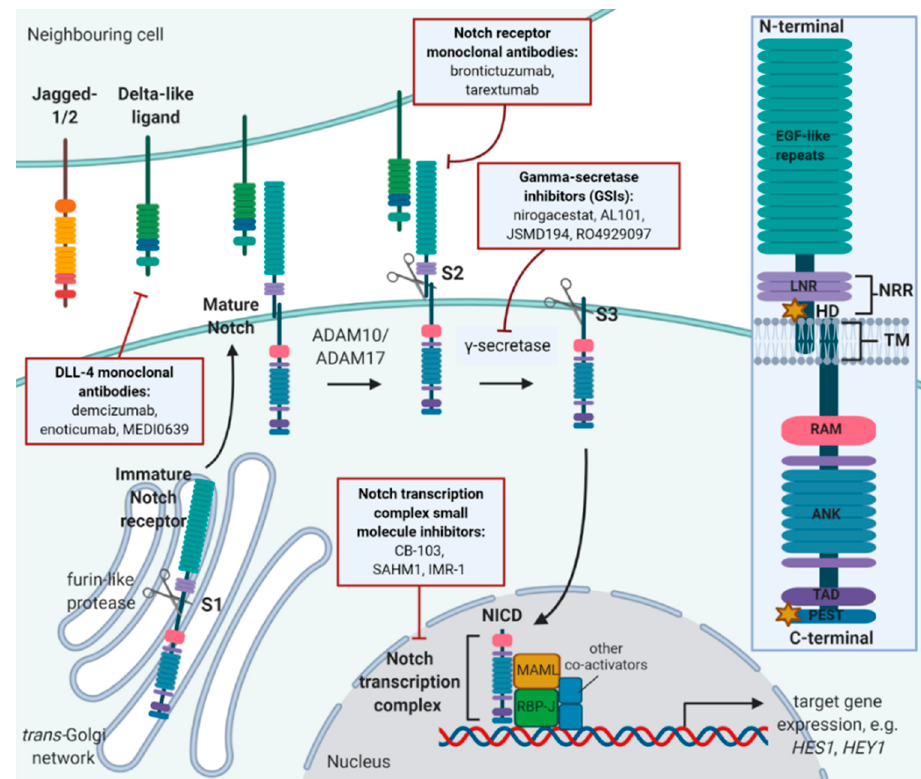
Figure 1. Notch signalling and strategies for pharmacological targeting of this pathway. Right Inset: Notch receptors consist of N-terminal EGF-like repeats, followed by three Lin12/Notch repeats (LNR) and the heterodimerisation (HD) domain, which together form the negative regulatory region (NRR). Next, there is a single transmembrane (TM) repeat, followed by an intracellular RBP-J-associated molecule (RAM), ankyrin repeats (ANK), a transcriptional TAD domain and a degradation PEST domain. Notch-activating mutations (labelled with the star) are commonly found in the HD and PEST domain. Main diagram: Immature Notch receptor is processed in the trans- Golgi network where a furin-like protease cleaves it at Site S1 within the HD domain, located between the LNR and the TM, creating the mature heterodimeric Notch receptor, sustained by NRR. Notch-specific ligands located on a neighbouring cell (e.g., Jagged-1/2 or Delta-like ligand (DLL-) 1/3/4) interact with the N-terminal of the mature Notch receptor, causing activation (i.e., release of its autoinhibited conformation). ADAM 10/17 matrix metalloproteinases cleave Notch at Site S2 located in TM (extracellular side). The remaining TM domain is cleaved by a gamma secretase at Site S3 (intracellular side). Notch intracellular domain (NICD) is released and translocates to the nucleus where it forms a complex with DNA-binding transcription factors RBP-J (CSL), mastermind-like (MAML) protein and other coactivator proteins and enzymes, and stimulates transcription of Notch target genes including the hairy/enhance of split 1 (HES) and Hes-related (HEY) families of transcription repressors, such as HES1 and HEY1 . There are numerous strategies to pharmacologically target Notch signalling including Notch receptor monoclonal antibodies, ligand-targeted antibodies (e.g., DLL-4 antibodies), gamma secretase inhibitors (GSIs) and Notch transcription complex small-molecule inhibitors.